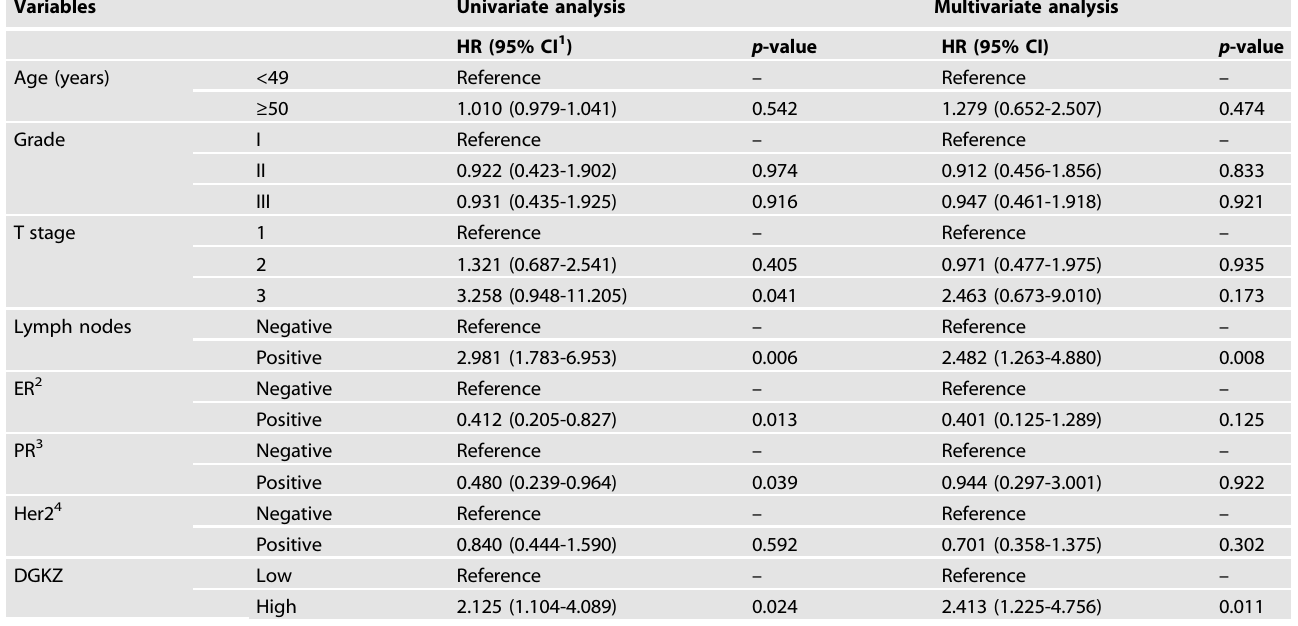
Table 2. The univariate analysis and multivariate analysis between clinicopathological characteristics and